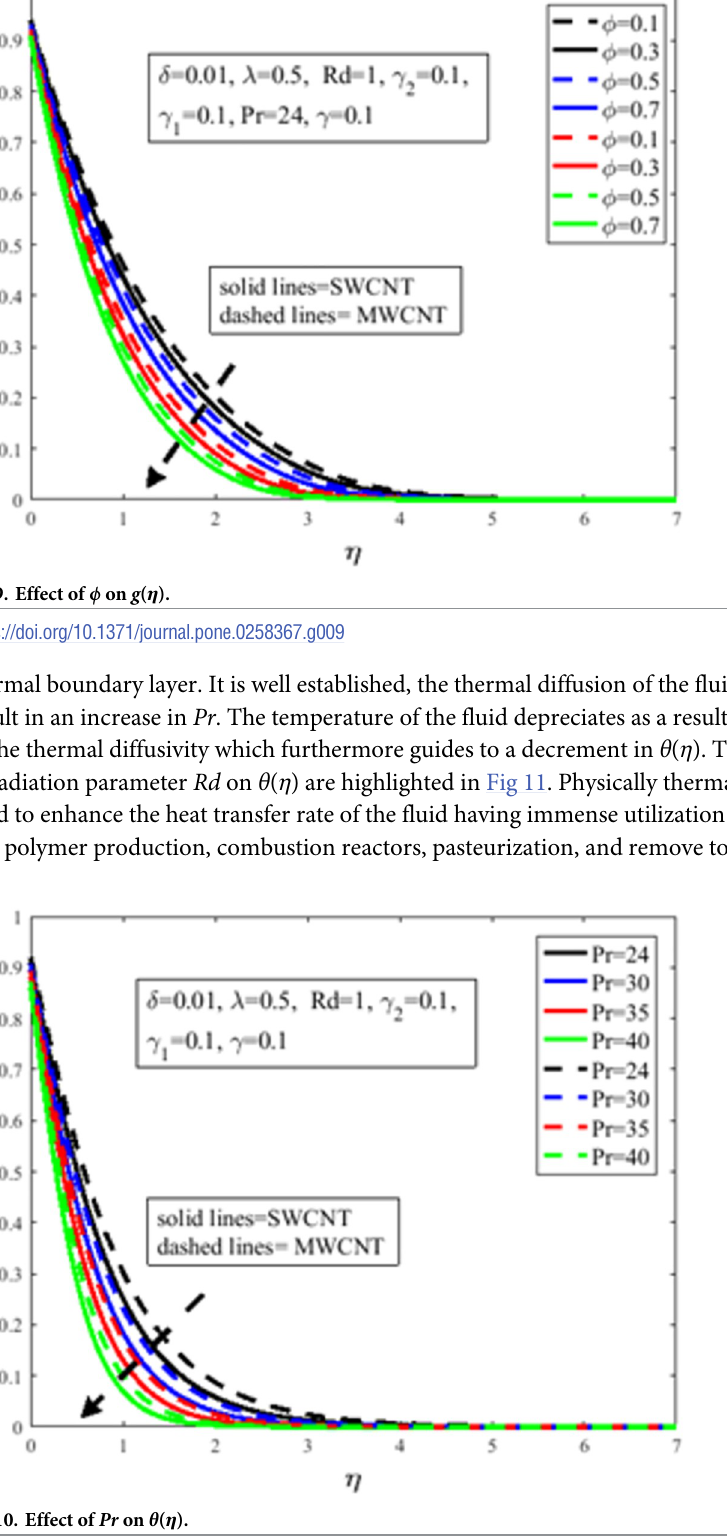
Fig 10. Effect of Pr on θ ( η